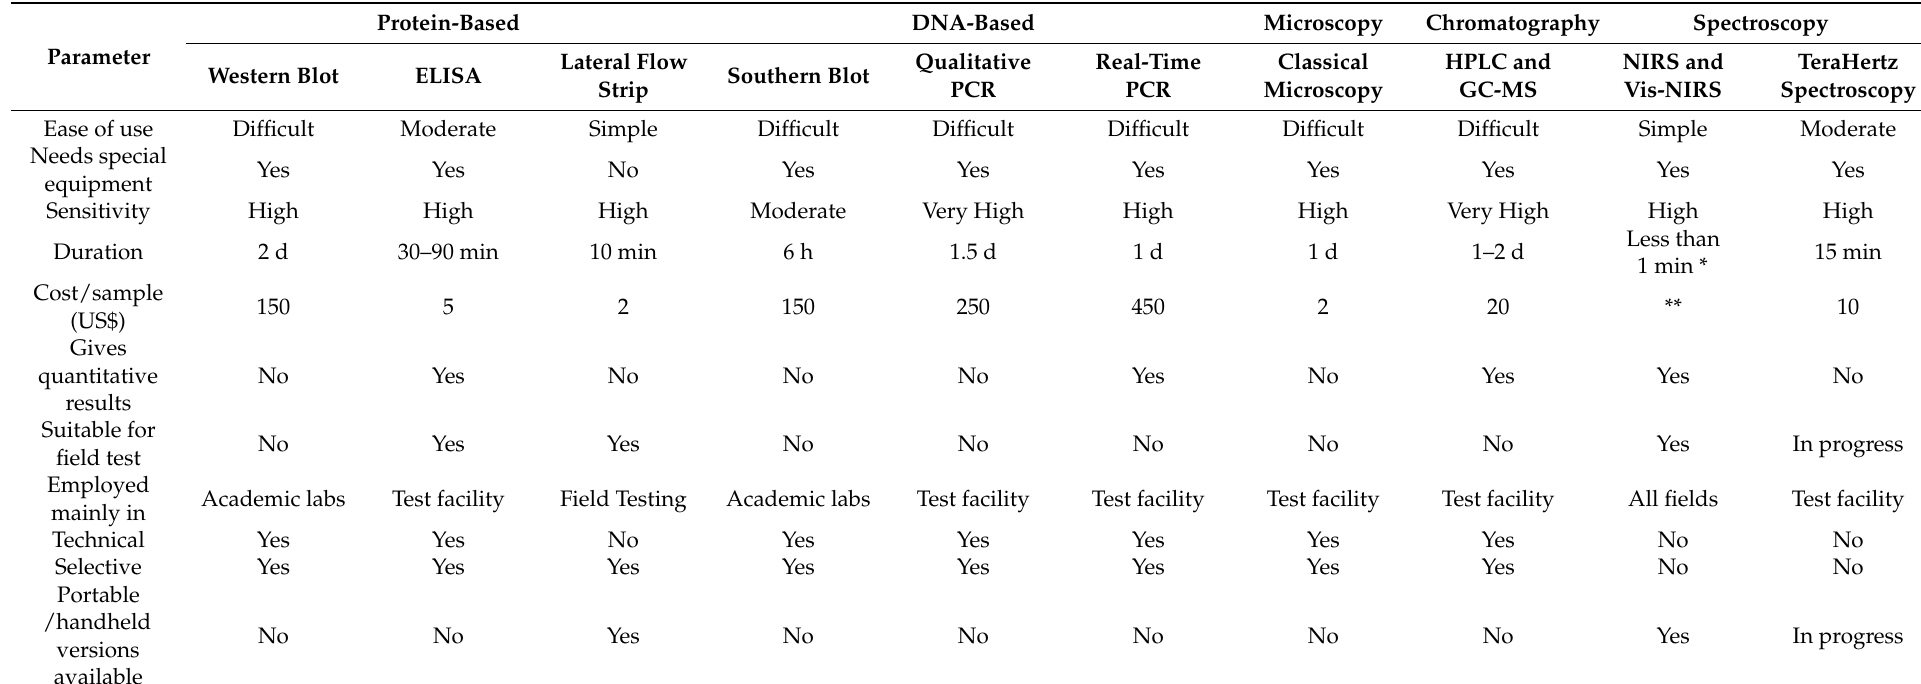
Table 1. The different detection methods for genetically modified